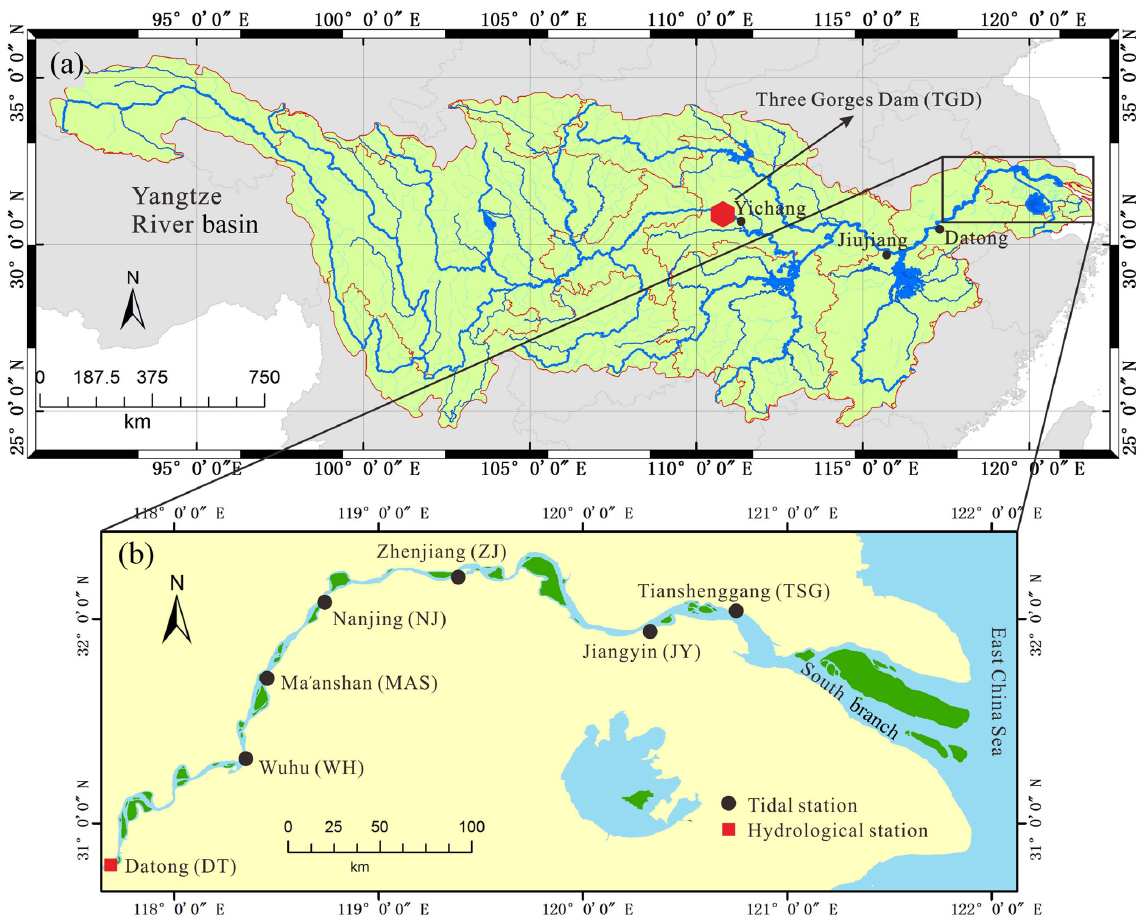
Figure 1. Maps of the Yangtze River basin (a) and Yangtze River estuary (b) with the location of tidal gauging and hydrological stations shown with black solid circles and red solid